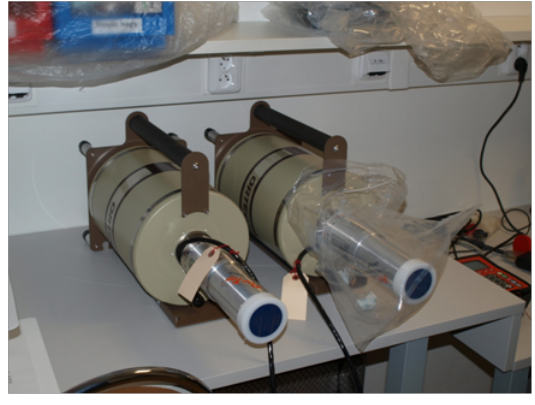
Figure 10. Positionable HPGe